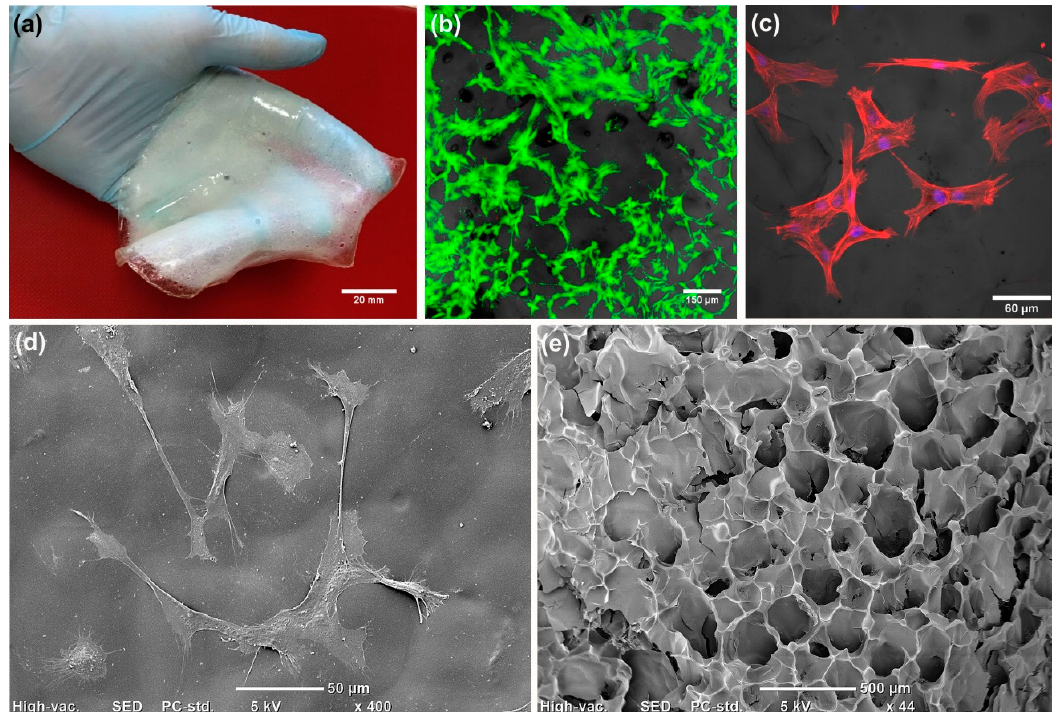
Figure 5. Dermal skin graft: ( a ) image presenting 2-mm thick chitosan/curdlan film (Polish patent application no. P.430456 [59]) for regenerative medicine application as dermal skin substitute; ( b ) CLSM image presenting human skin fibroblasts stained with calcein-AM (green fluorescence of viable cells) and propidium iodide (red fluorescence of dead cells) grown on the surface of the chitosan/curdlan film that was visualized by application of Nomarski contrast; ( c ) CLSM image presenting human skin fibroblasts stained with AlexaFluor635-Phalloidin (red fluorescence of cytoskeleton) and DAPI (blue fluorescence of nuclei) grown on the surface of the chitosan-based thin membrane that was visualized by application of Nomarski contrast; ( d ) scanning electron microscope (SEM) image presenting well-attached human skin fibroblasts on the surface of the chitosan hydrogel; ( e ) SEM micrograph presenting porous foam-like chitosan-based wound dressing (Polish patent application no. P.430455 [60]) for regenerative medicine application. 3.2.1. Cells Used for Cellular Skin Graft Production Cellular skin substitutes are produced using fibroblasts (dermal grafts), keratinocytes (epidermal grafts) or both fibroblasts and keratinocytes (dermo-epidermal grafts). Importantly, it was observed that co-culture systems have advantages over monocultures since fibroblasts have the ability to promote keratinocyte growth and differentiation by either GF release or direct cell-cell contact, whereas GFs secreted by keratinocytes stimulate fibroblast proliferation (Figure 6) [2,49,50]. Fibroblasts and keratinocytes may be obtained by either direct isolation from a skin biopsy or differentiation of stem cells toward mature skin cells. Many research articles present fabrication of tissue-engineered skin grafts using fibroblast or keratinocyte cell lines, e.g. , BJ-5ta cells, which are human telomerase reverse transcriptase (hTERT)-immortalized human newborn foreskin fibroblasts [61]; HFF-1 cells, which are normal human newborn foreskin fibroblasts [62]; N/TERT-1 cells, which are hTERT-immortalized human newborn foreskin keratinocytes with spontaneous loss of p16 expression [61,63]; HaCaT cells, which are spontaneously transformed aneuploid immortal keratinocytes from adult human skin [62]; or HEK001 cells, which are human adult epidermal keratinocytes transformed with human papillomavirus 16 [64]. Nevertheless, it is known that cell lines may reveal a completely different gene expression compared to primary cells [65,66], and thus primary cultures should be preferentially used for both skin graft production and biocompatibility testing of new biomaterial-based skin substitutes. Indeed, most cellular artificial skins were developed using either isolated primary fibroblasts and/or keratinocytes [67–70] or primary culture